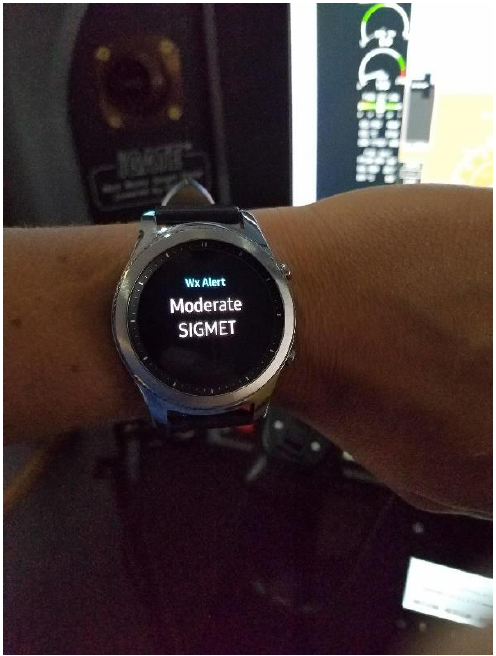
Figure 4. Summary statement for incoming weather message, displayed on a connected smart-watch.